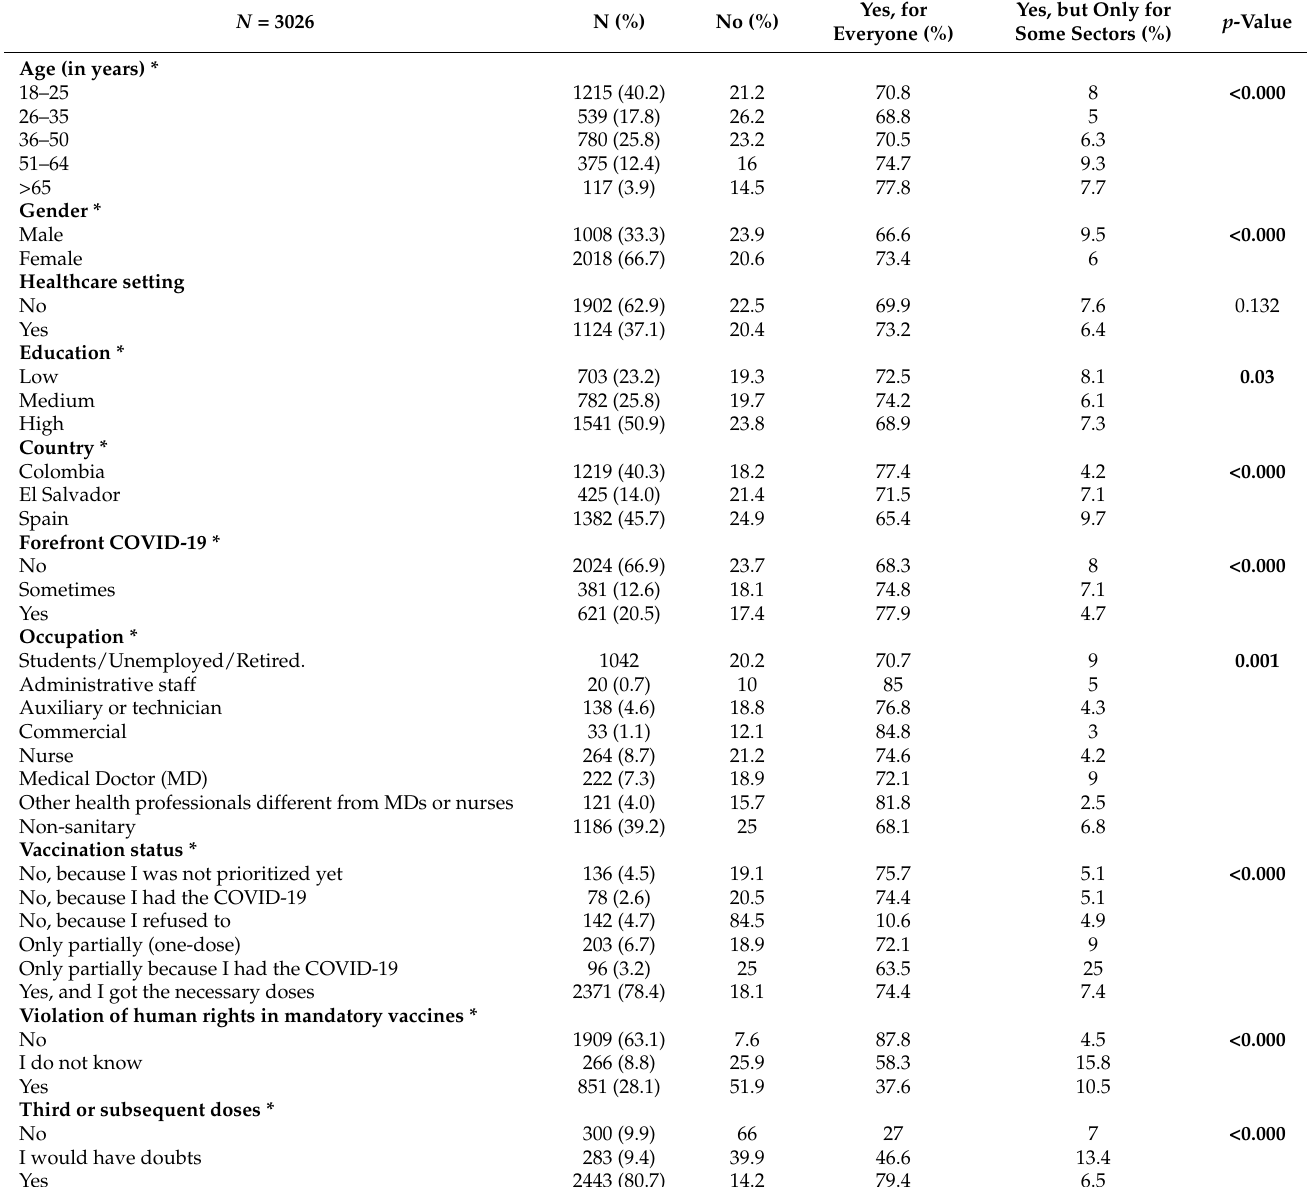
Table 1. Sample characteristics according to their attitude towards mandatory COVID-19 vaccination: Responses options were: No, vaccines should not be mandatory for anyone ( n = 657, 21.7%),